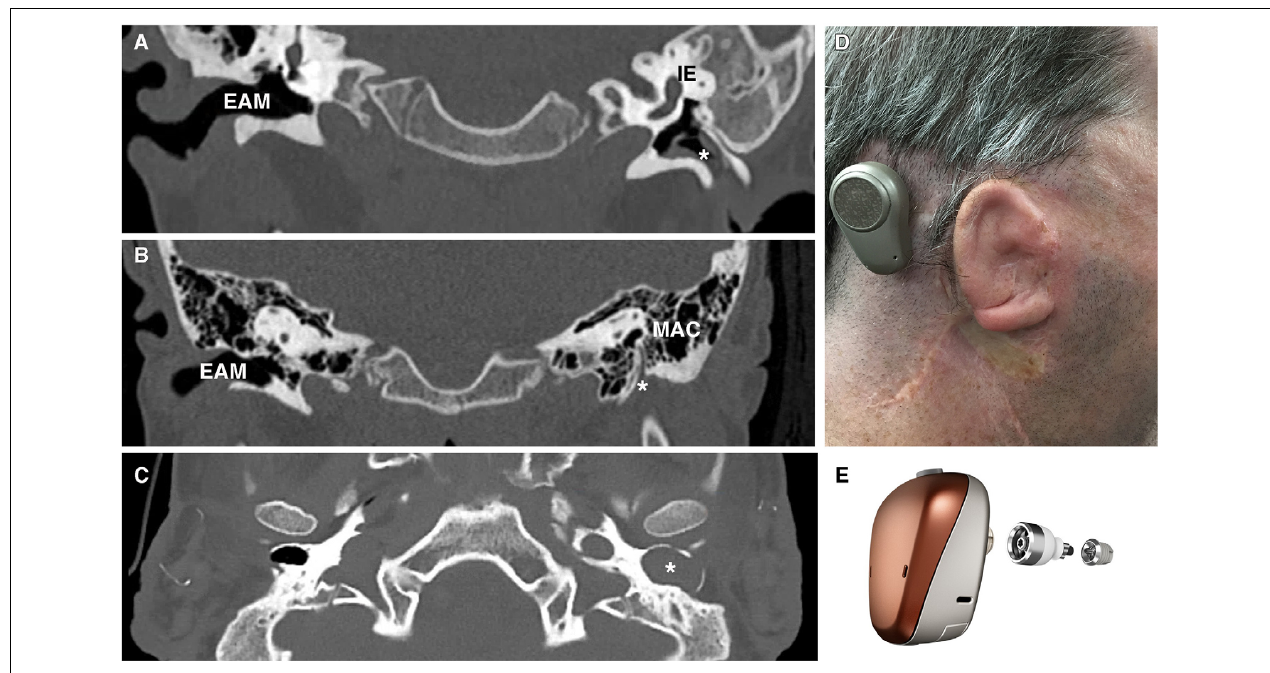
FIGURE 4 | Patient photograph and scans of congenital aural atresia. (A) Congenital aural stenosis. Coronal CT scan shows a normal, patent right ear canal and a stenotic left ear canal marked by *. (B) Complete congenital aural atresia. Coronal CT scan shows a normal ear canal on the right and an atretic plate on the left with no ear canal. (C) Congenital aural stenosis and cholesteatoma. Axial CT scan of a patient with congenital aural stenosis and left-sided cholesteatoma. The bony ear canal has been widened and remodeled by the collecting keratin (marked by *). (D) Photograph of a patient with Treacher-Collins syndrome and complete aural atresia of the left ear canal. The patient has been fitted with an osseointegrated hearing device visible behind the pinna. (E) Example of an osseointegrated device. Computer-generated image of a BAHA Connect (Image courtesy of Cochlear Bone Anchored Solutions AB, ©2020). EAM, external auditory meatus; IE, inner ear; MAC, mastoid air